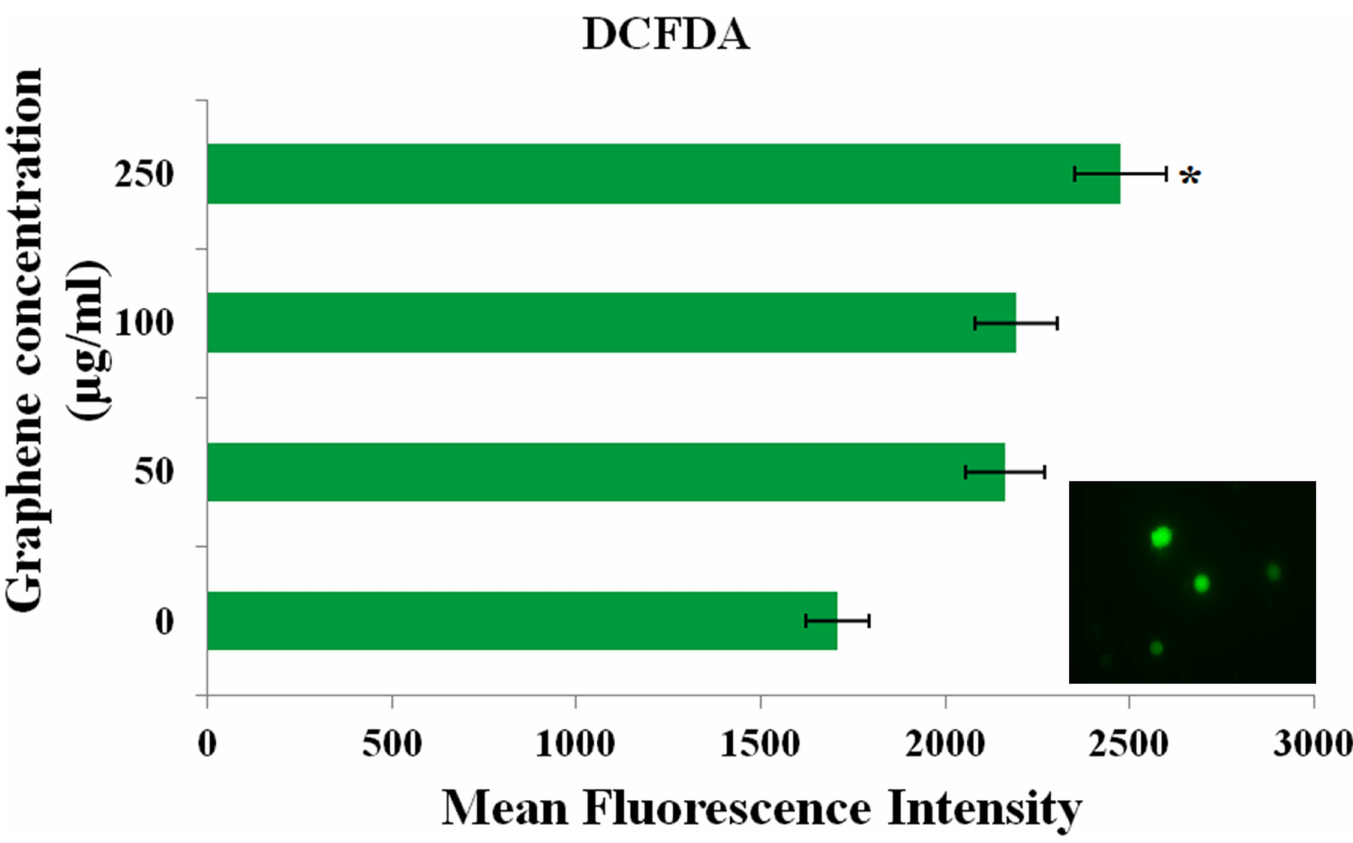
Fig 12. ROS generation in human PBMCs induced by